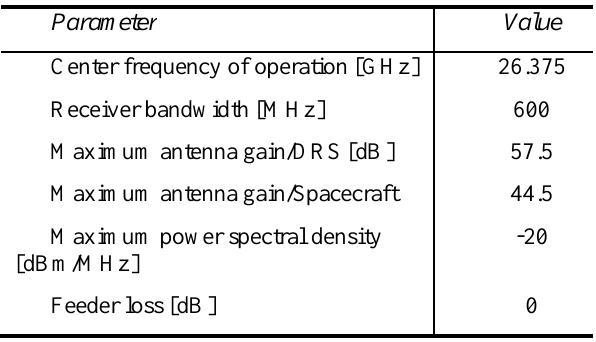
Table 1. Inter-satellite Service System